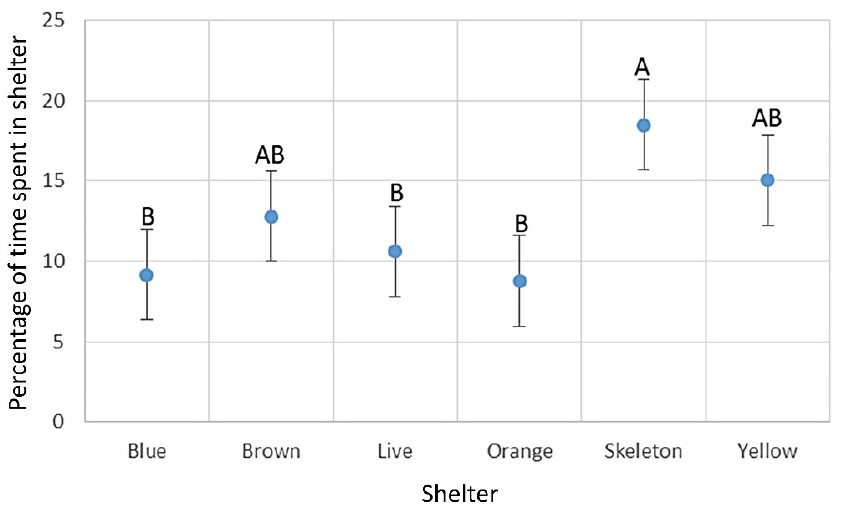
Figure 6. Time spent within each shelter. Means ± standard deviation. Percentage of time P. squamipinnis spent inside or less than 2 cm away from various models of S. pistillata. F (5,473) = 3.8544; p = 0.00196; two-way ANOVA. A Tukey post hoc test was used to show a significant difference in fish shelter preference; p < 0.05.